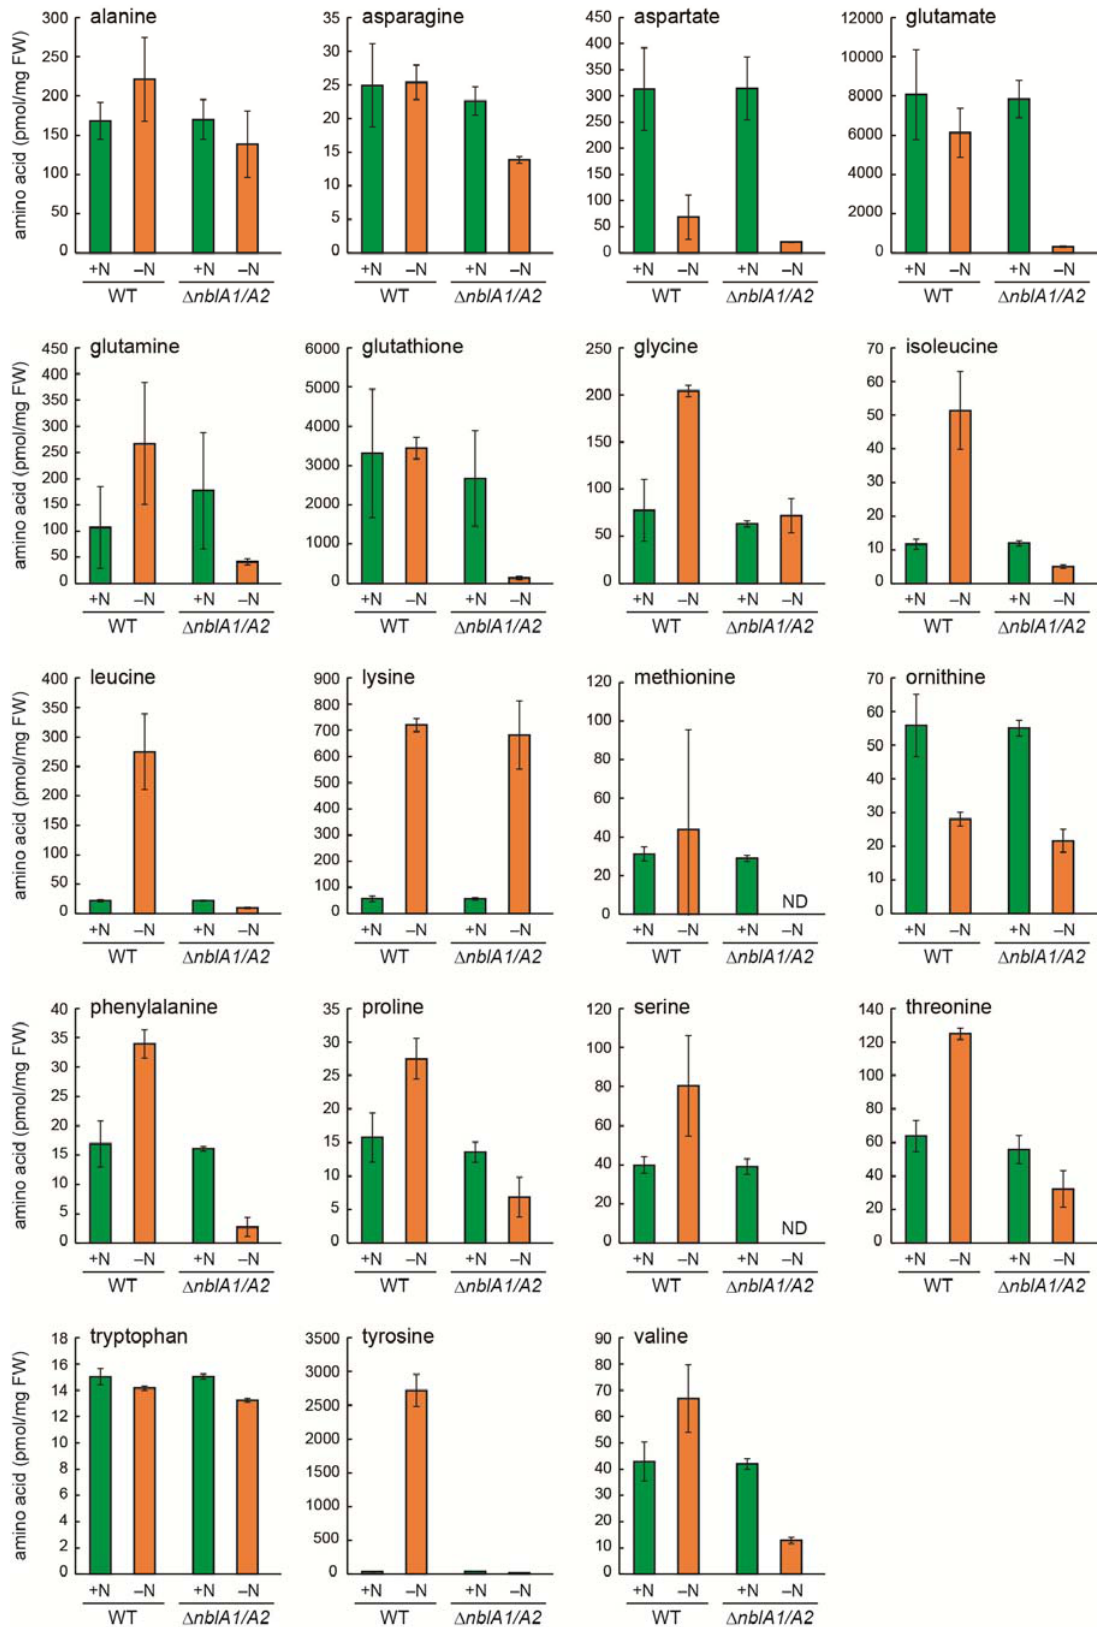
Figure 5. Amino acid pools in WT Synechocystis and the nblA1/A2 mutant ( ∆ nblA1/A2 ) after 24 h in nitrogen-sufficient (+N) or nitrogen-deficient (–N) medium. Standard deviation is shown from three independent experiments. ND, not